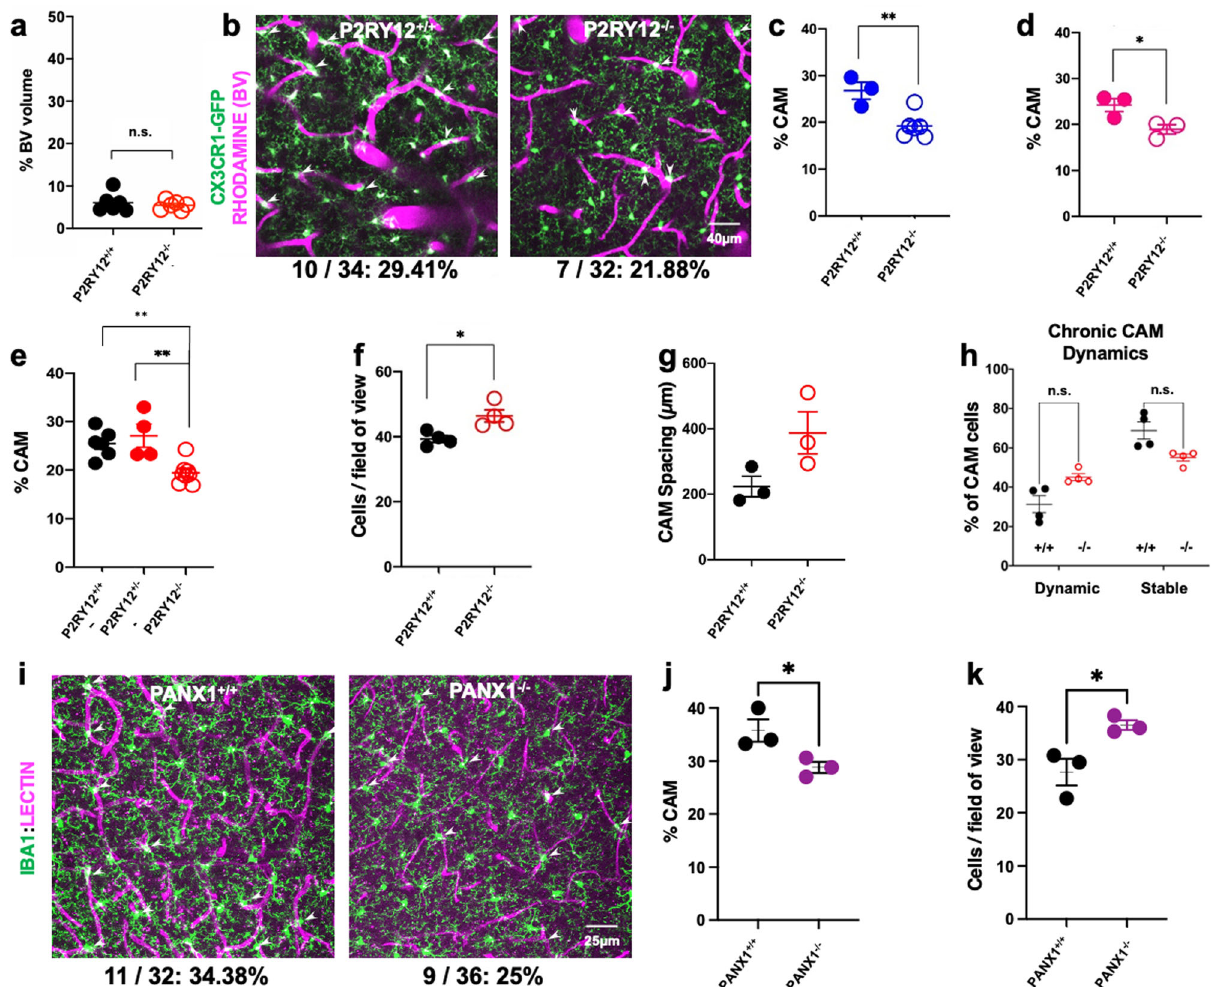
Fig. 4 P2RY12- and PANX1-dependent regulation of CAM interactions. a Quanti fi cation of the blood vessel volume when compared to total brain volume in P2RY12 + / + and P2RY12 − / − mice. n = 6 mice each. b – d Representative 20- µ m-thick two-photon projection images (p) and quanti fi cation in males ( c , n